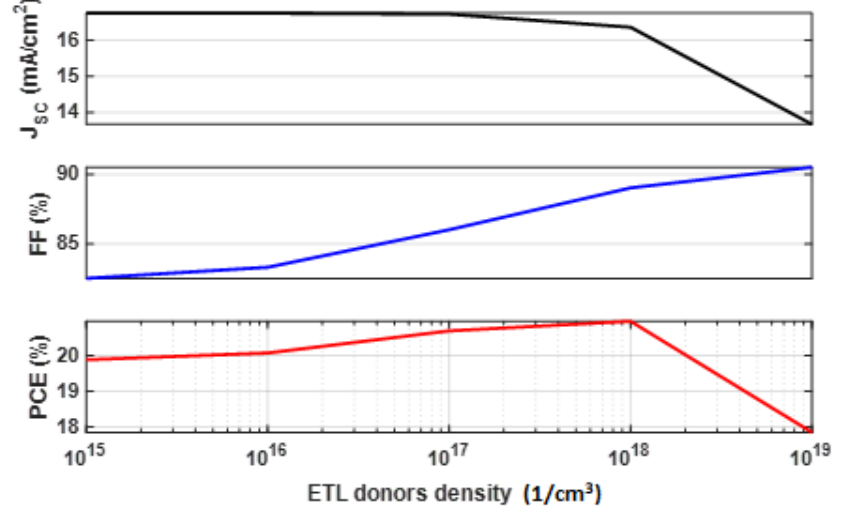
Figure 7. Effect of donor density of ETL (WS 2 ) on the performance parameters.